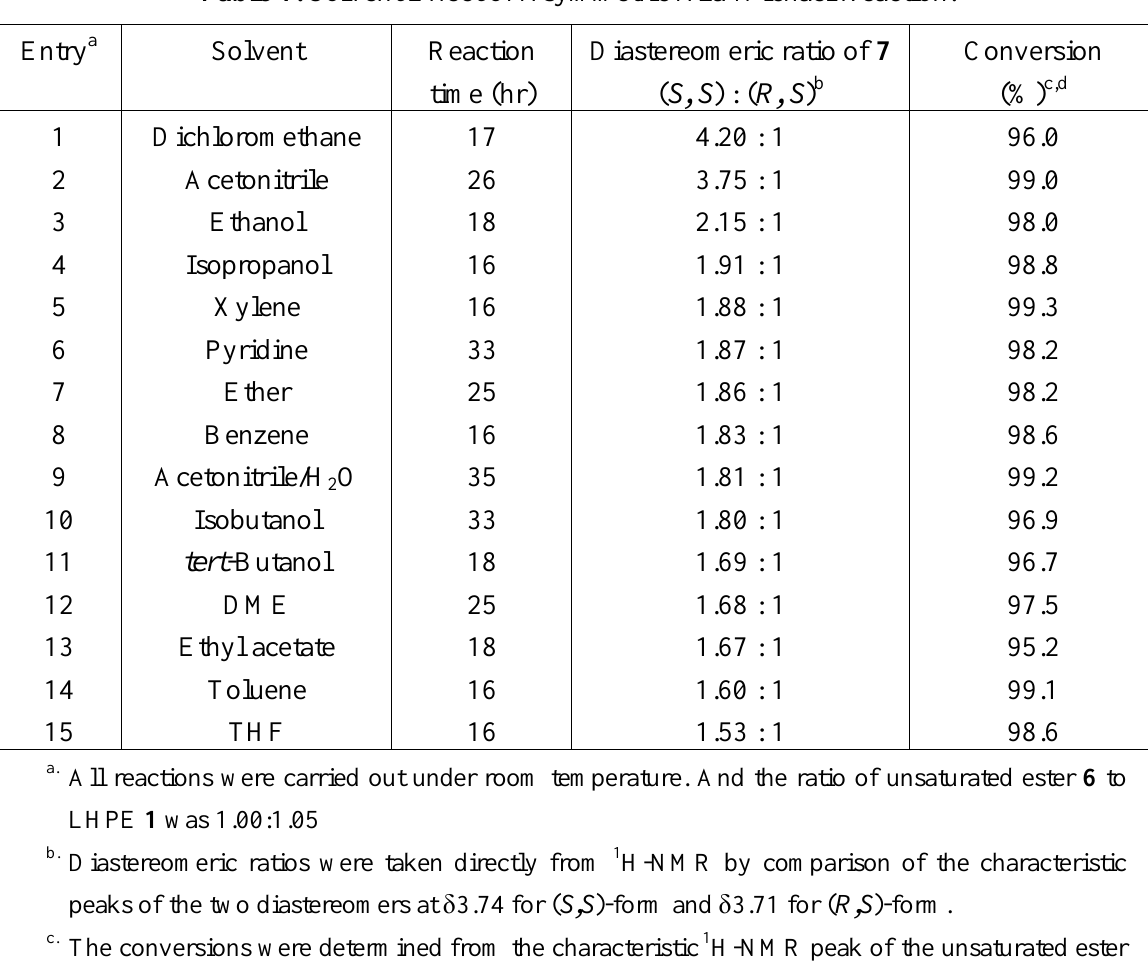
Table 1. Solvent Effect of Asymmetric Aza-Michael